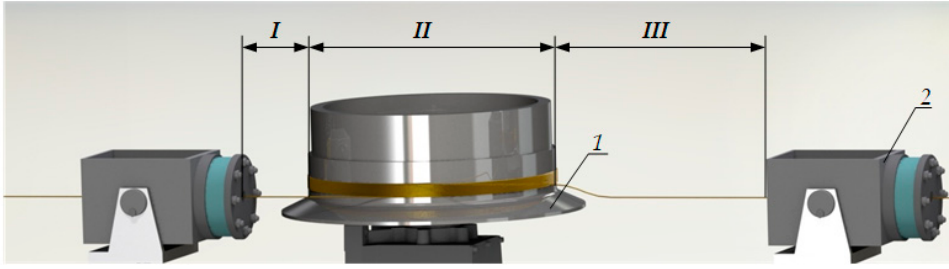
Figure 1. Wire drawing scheme on straight-line machines: 1—drawing drum; 2—die. The heat q w / out is transferred to the environment (Sections I and III ) and to the wire drawing drum (Section II ) (Figure